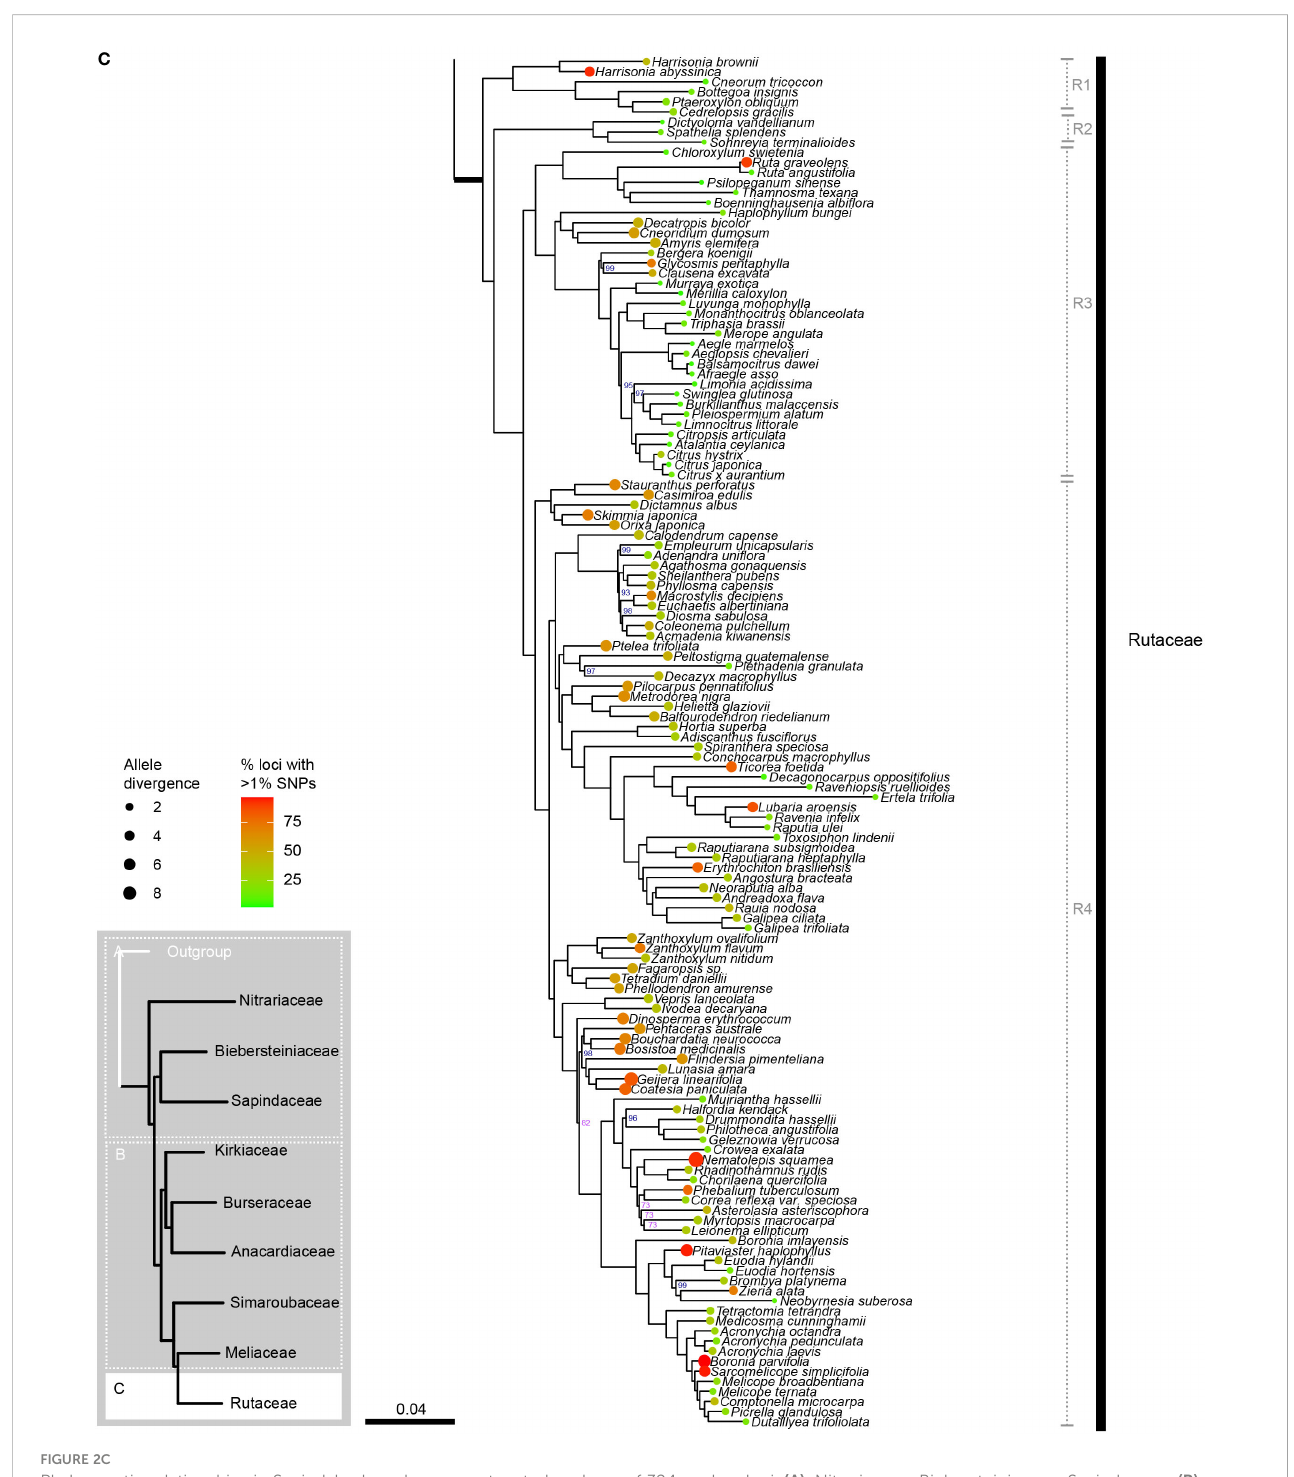
FIGURE 2C Phylogenetic relationships in Sapindales based on concatenated analyses of 324 nuclear loci. (A) , Nitrariaceae, Biebersteiniaceae, Sapindaceae; (B) , Kirkiaceae, Burseraceae, Anacardiaceae, Simaroubaceae, Meliaceae, and (C) , Rutaceae. Numbers on branches indicate support for nodes with low support (BS<90%; violet) or moderate to high support (BS>90%; blue); branches without bootstrap values have maximum support (BS = 100%). Thick branches indicate stems of families, with major family clades annotated in grey to the right. Tip circle colour indicates the percentage of paralogous loci (= percentage of loci with >1% SNPs), and tip circle size is proportional to allele divergence for the